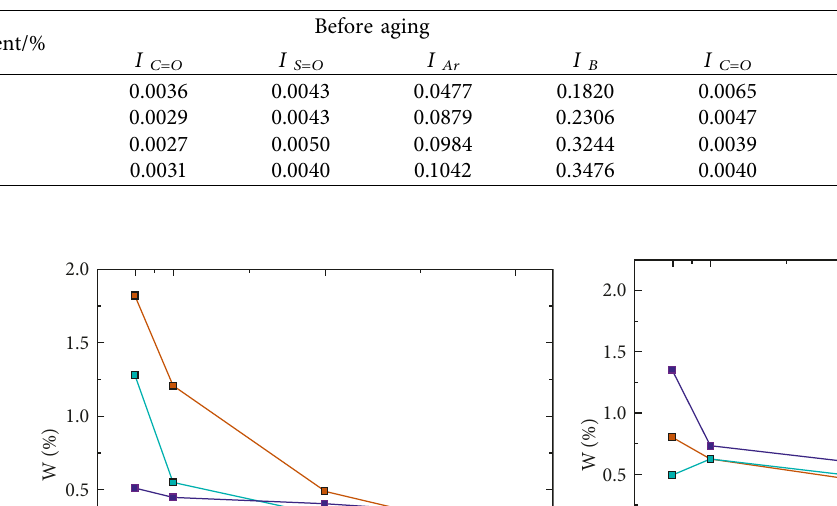
Table 9: Effect of Irgafos168 on the functional group index of